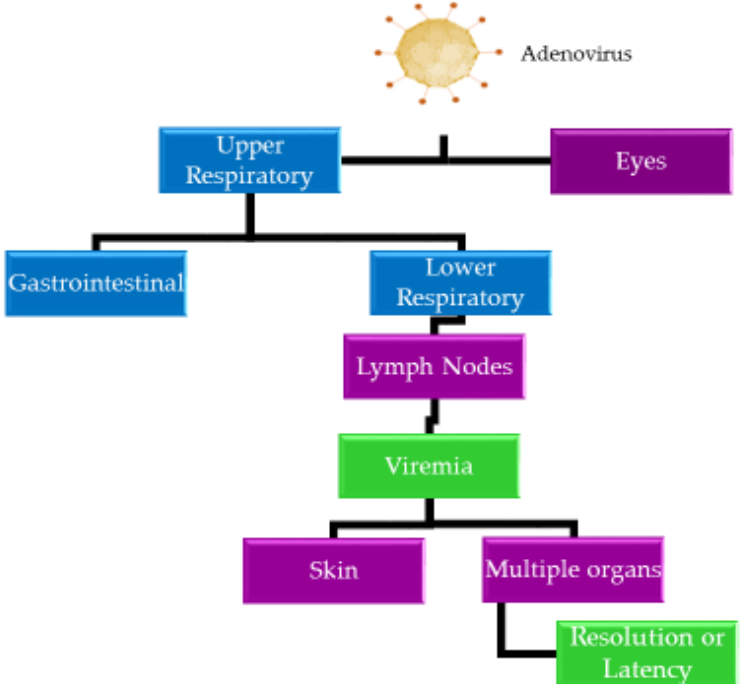
Figure 2. Mechanisms of HAdV spread within the body. HAdV may be transmitted directly or indirectly. These viruses can adversely impact body systems and cause organ dysfunction. HAdV can evade the immune response and produce persistent or latent infections. The organs are represented in purple, while the body systems are represented in blue. The biological status of the infected host is indicated in